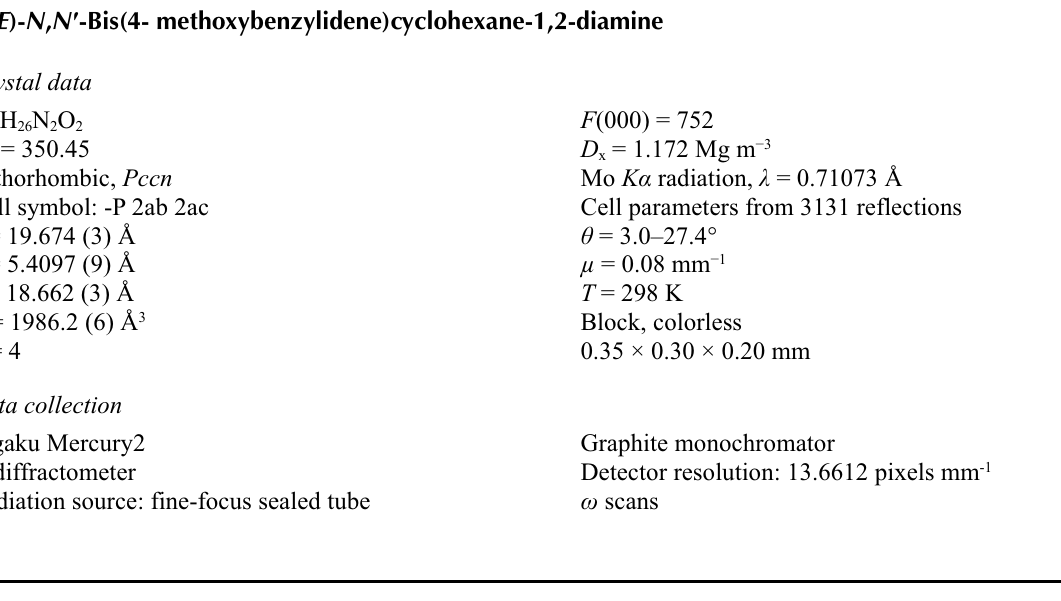
Figure 1 A view of the title compound with the atom numbering scheme, symmetry related atoms, (-x+1/2, -y+1/2, z) denoted by A. Displacement ellipsoids were drawn at the 30% probability